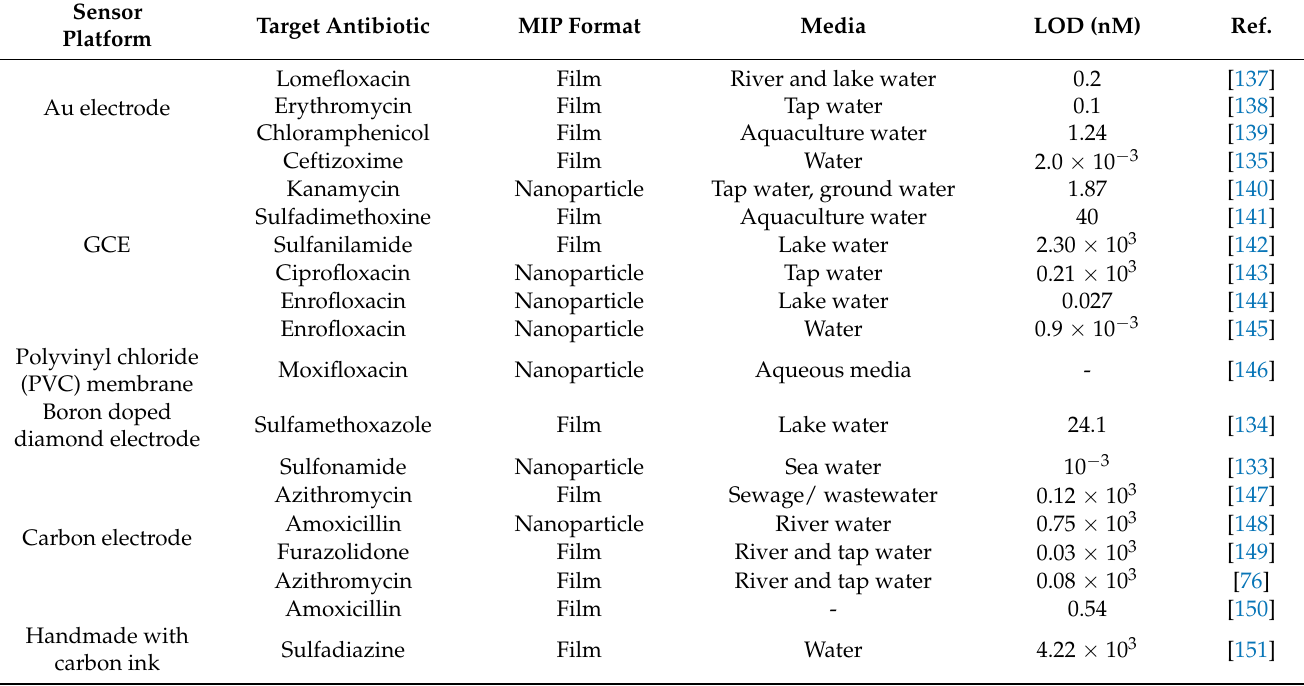
Table 4. Antibiotic MIPs combined with electrochemical label-free sensor platforms and their